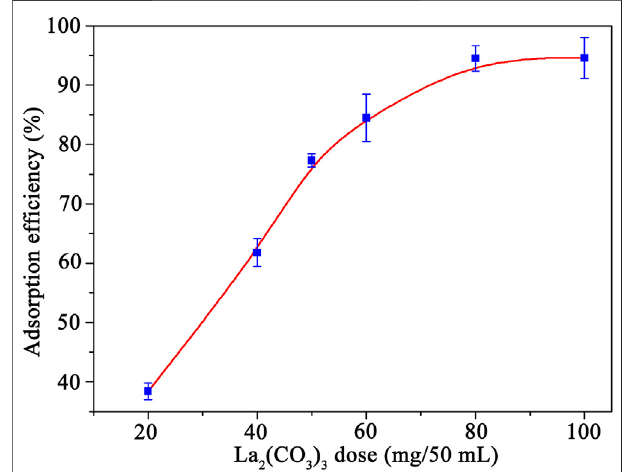
FIGURE 4 | Effect of La 2 (CO 3 ) 3 dosage on the adsorption amount of PO 43 − . Initial concentration of PO 43 − : 200 mg L − 1 , temperature: 298.15 K, and pH: 6.8.